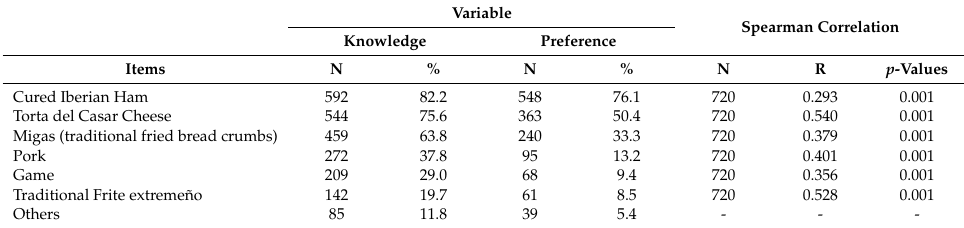
Table 4. Knowledge and preferences about C á ceres traditional